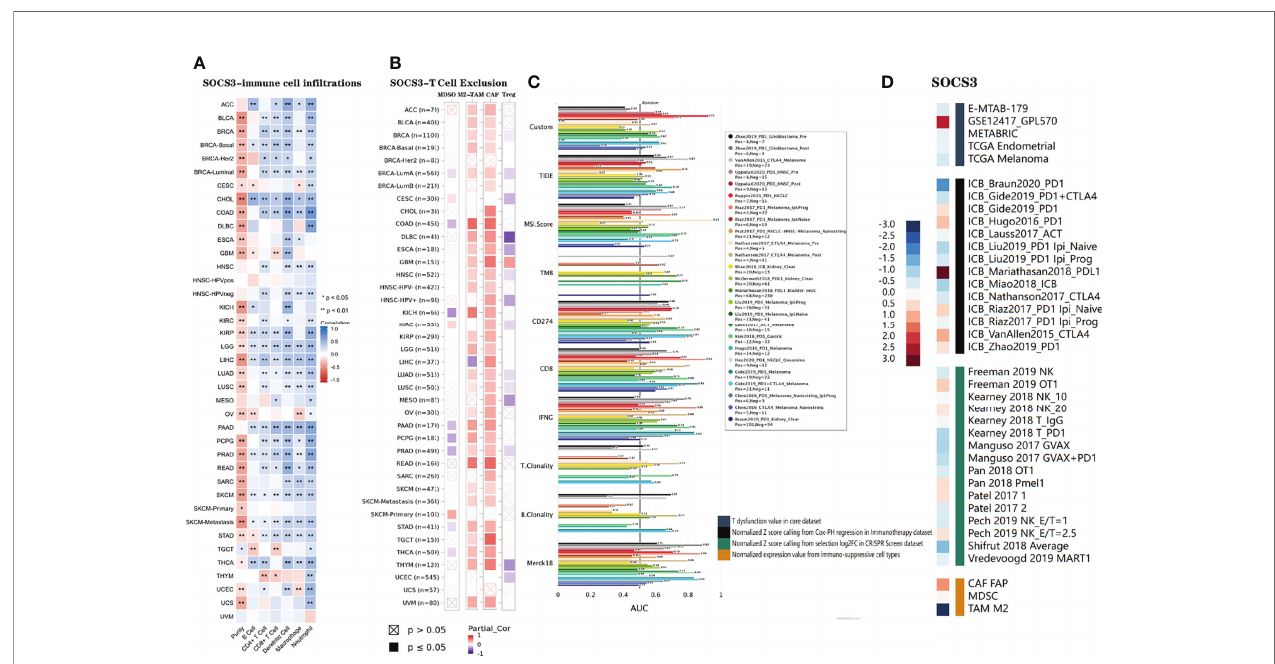
FIGURE 7 | (A, B) Relevance between SOCS3 expression status and six immune in fi ltration cells and four immunosuppressive cells in different cancers. Purity- corrected partial Spearman ’ s rho values and statistical difference were employed to account for the relationship. (C) Correlations between SOCS3 and standardized tumor immune evasion markers in immune checkpoint blockade cohorts. The predictive abilities of the targets on the ICB response were assessed by AUC. (D) Correlations between SOCS3 and lymphocyte-mediated tumor killing in T dysfunction, immunotherapy, CRISPR screen, and immune-suppressive cell types. MDSCs, myeloid-derived suppressor cells; M2-TAMs, M2 subtype of tumor-associated macrophages; CAFs, cancer-associated fi broblasts; Tregs, regulatory T cell. **p < 0.01, *p <